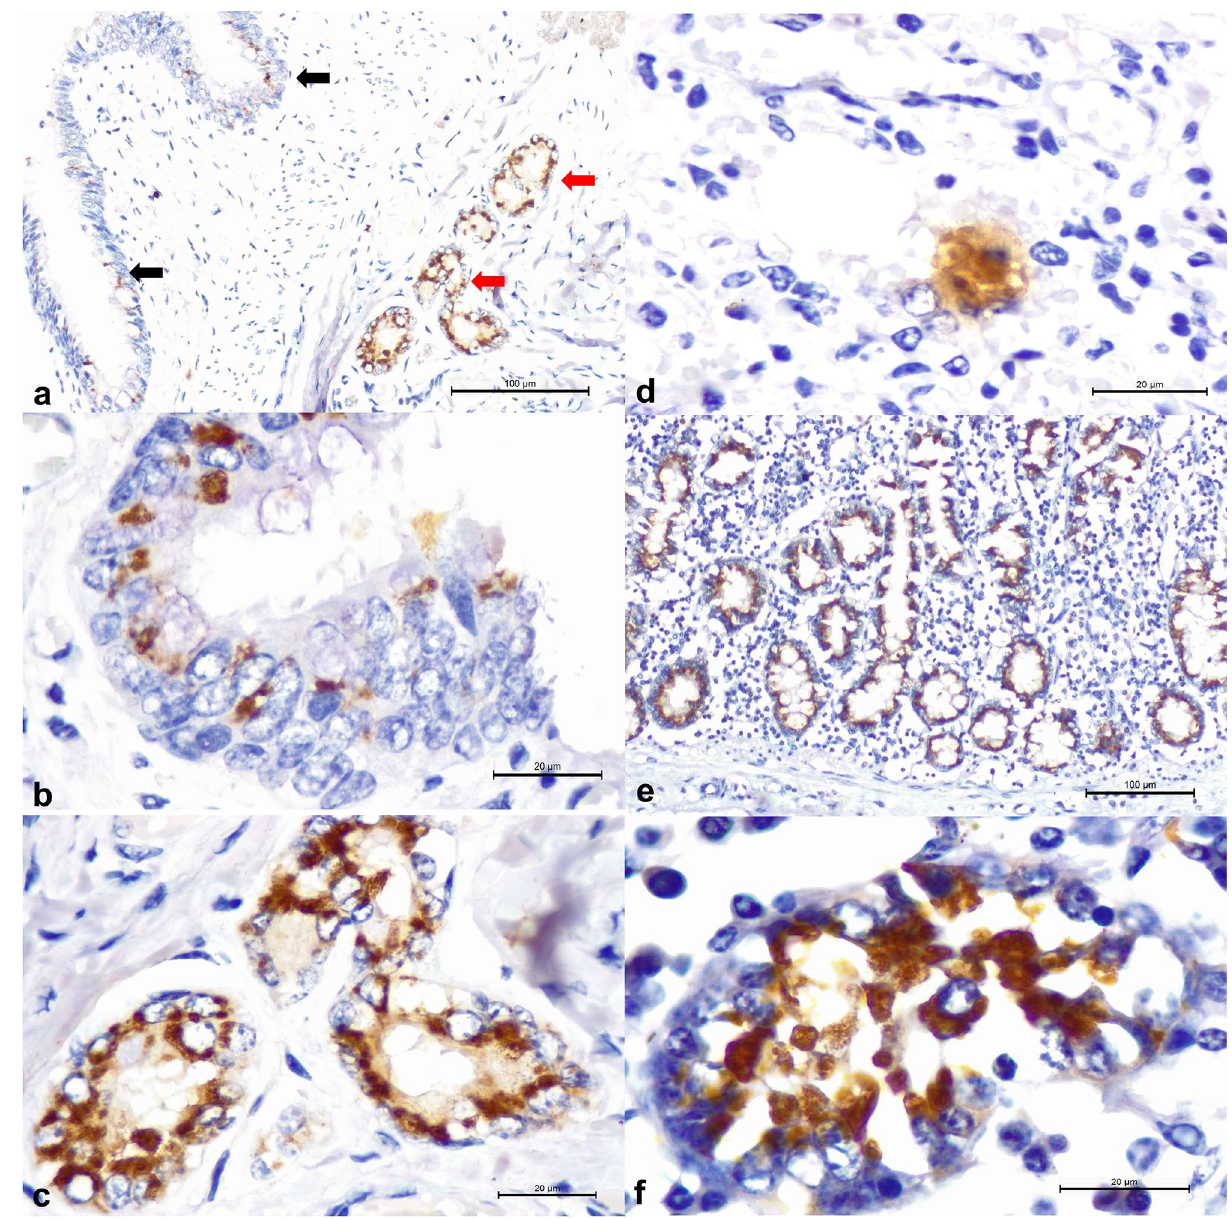
Figure 2. Immunohistochemical identification of MCFV antigens in the lungs and intestines of cattle infected with OvGHV2. There is positive immunoreactivity to MCFV antigens within the epithelial cells of the bronchus (black arrows) and the peribronchial glands (red arrows) of the calf with interstitial pneumonia ( A ); closer view of the intracytoplasmic accumulations of antigens of MCFV within epithelial cells of the bronchus ( B ), peribronchial glands ( C ), and a pneumocyte ( D ). Observe positive intracytoplasmic immunoreactivity to MCFV antigens within epithelial cells of intestinal crypts ( E ), which can be better appreciated at a closer view ( F ). Immunoperoxidase counterstained with Hematoxylin. Bars ( A , E ) 100 µm; ( B – D , F ) 20